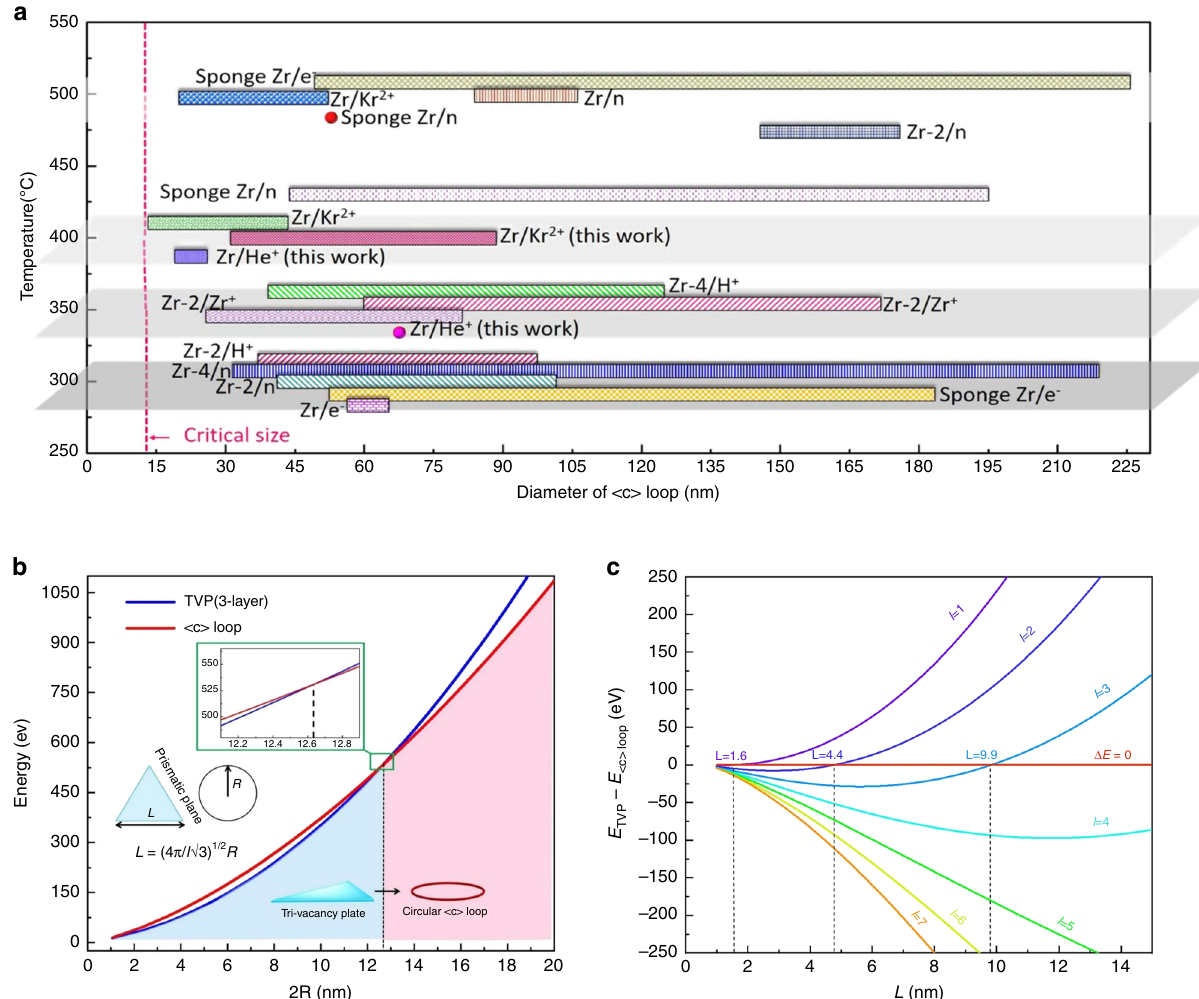
Fig. 4 Size distribution and energy of <c> loops and triangle-vacancy platelet (TVPs). a The size of the <c> loops produced at different irradiation temperatures in Zr alloys 14 – 25 . The pink line marks the lower limit on the size of the <c> loops. b Competition of the energy of a <c> loop (blue curve) with a three atomic layer TVP. The inserted images are illustrations of a circular <c> loop and TVP. c Highlight of the difference in the energy of a TVP with a <c> loop at various